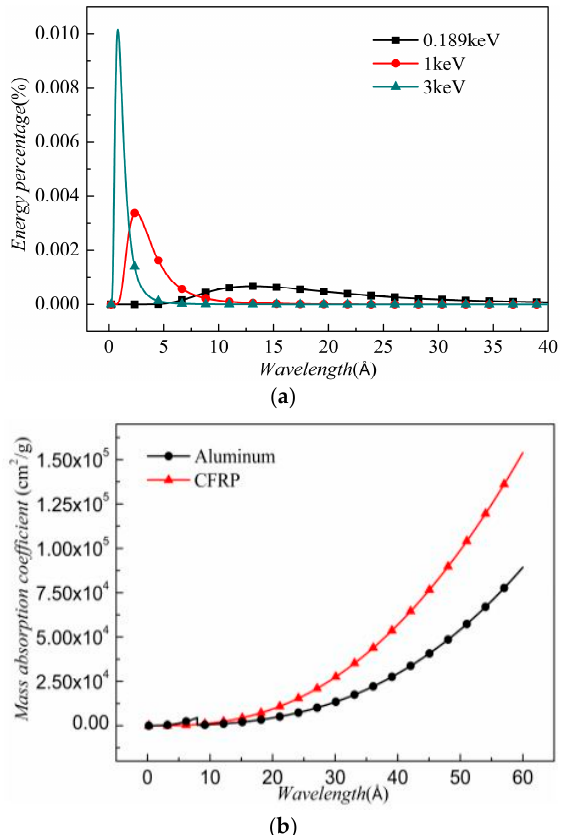
Figure 1. ( a ) Energy percentage; and ( b ) mass absorption coefficient.